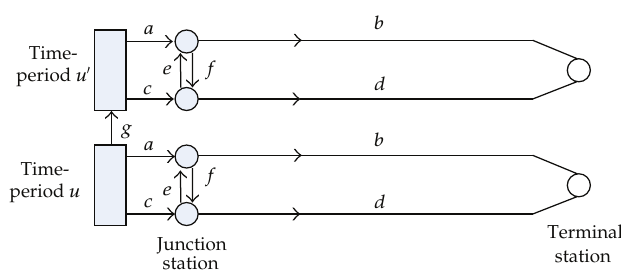
Figure 1: The process that passengers choose suboptimal schemes to travel.